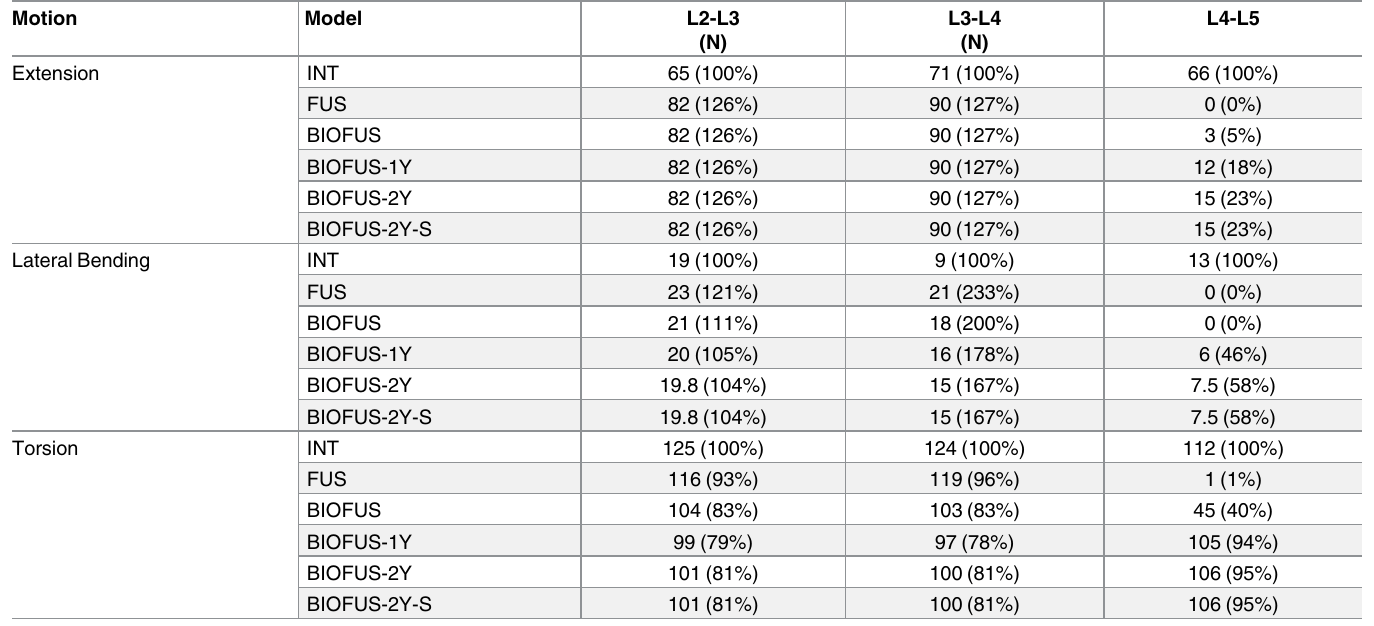
The percentages indicate the facet joint forces of all models normalized by the facet joint forces of INT